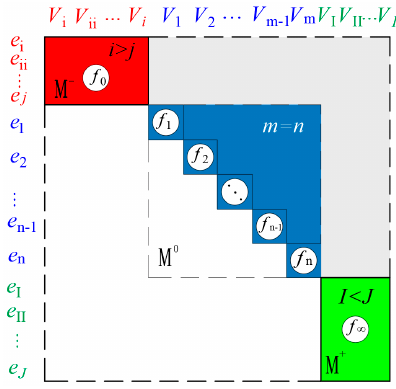
Figure 5. Diagram and principle of the Dulmage–Mendelsohn (DM) decomposition, where Figure 5. e (cid:3036) −e (cid:3037) , e (cid:2869) −e (cid:3041) , e (cid:2893) −e (cid:3011) represent the equations, 𝑉 (cid:3036) −𝑉 (cid:3037) , 𝑉 (cid:2869) −𝑉 (cid:3041) , 𝑉 (cid:2893) −𝑉 (cid:3011) represent the system variables, and 𝑓 (cid:2868) −𝑓 (cid:2998) represent the fault variables.